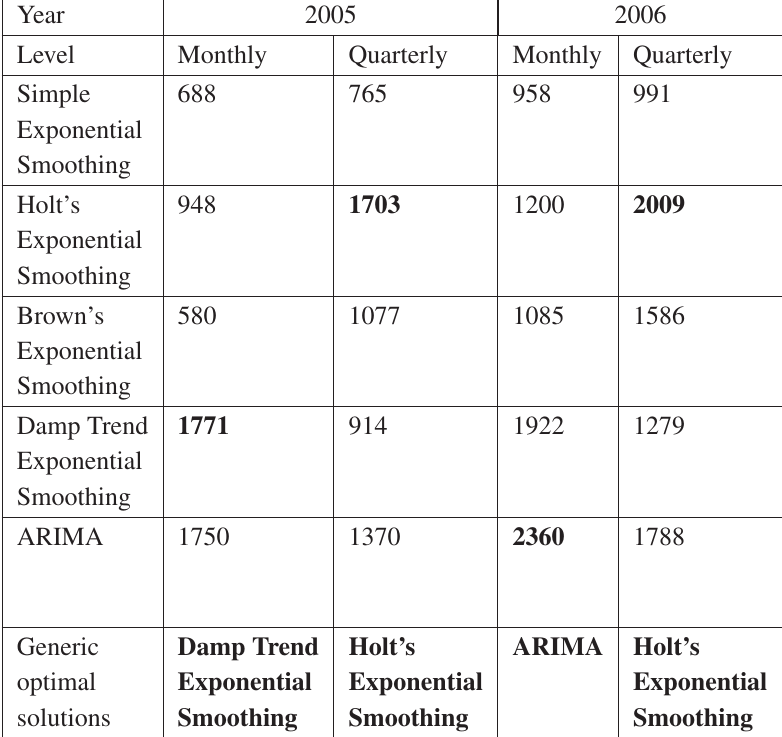
Table 2. Generic solutions in 2005 and